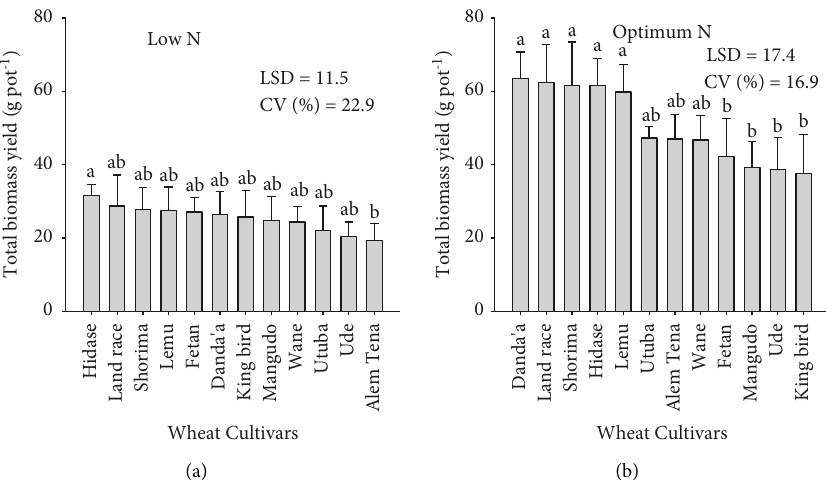
Figure 3: Total biomass yield of wheat cultivars under low and optimum N supply. Bars followed by similar letters under similar N level are not significantly different from each other at 5% probability level.